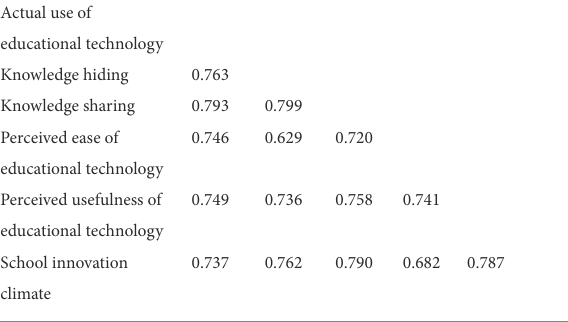
TABLE 5 Heterotrait-Monotrait